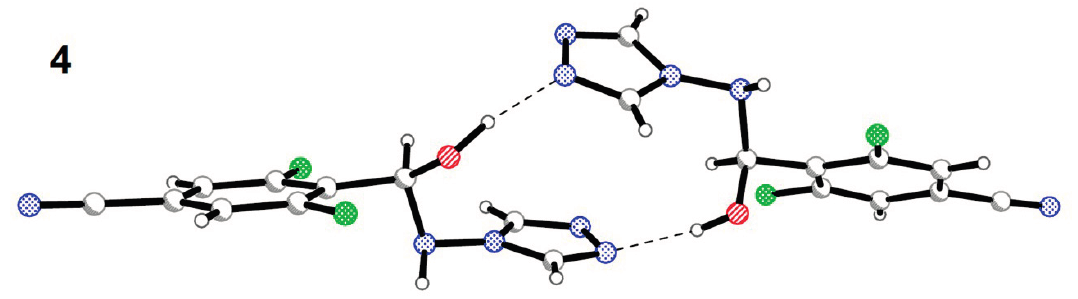
Figure 7. Formation of a dimer in the crystal structure of hemiaminal 4